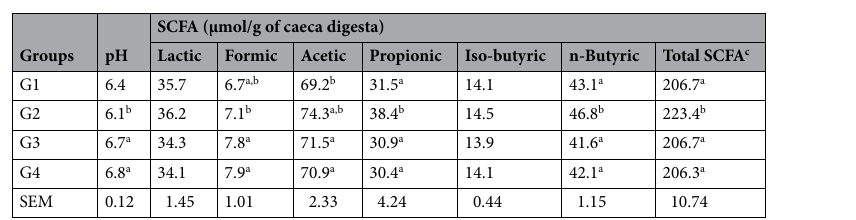
Table 3. In vivo caeca pH and short chain fatty acids levels (SCFA). Mean values assigned different letter superscripts within a criterion differ, p ≤ 0.05. c Summation of lactic, formic, acetic, propionic, iso-butyric, and n-butyric